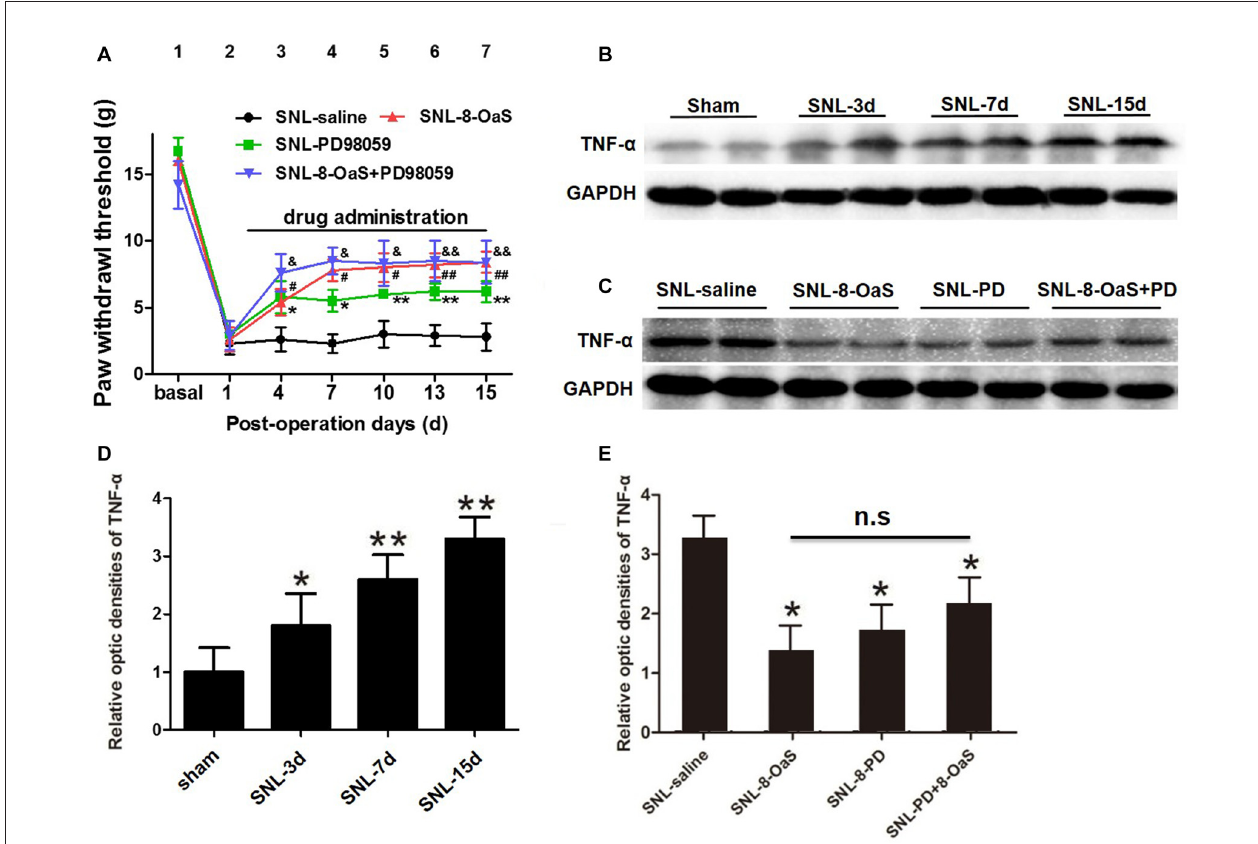
FIGURE 7 | 8-OaS suppressed SNL-induced spinal tumor necrosis factor-alpha (TNF- α ) expression via inhibiting ERK activation. Both administration of 8-OaS and PD98059 increased mechanical paw withdrawal threshold (PWT) of the SNL model. But co-treatment of 8-OaS and PD98059 did not result in further significant increases in PWT compared to the 8-OaS group and the PD98059 group (A) . ∗ P < 0.05, ∗∗ P < 0.01, SNL-PD98095 group compared with SNL-saline group. # P < 0.05, ## P < 0.01, SNL-8-OaS group compared with SNL-saline group. & P < 0.05, && P < 0.01, SNL-8-OaS+PD98095 group compared with SNL-saline group. SNL surgery increased the expression of TNF- α within the ipsilateral spinal dorsal horn from POD 3 to 15 (B,D) . ∗ P < 0.05, ∗∗ P < 0.01, compared with the sham group. n = 4 in each group. The expression of TNF- α were inhibited in 8-OaS and PD98059 treated groups but co-treatment of 8-OaS and PD98059 did not lead to further inhibition of TNF- α (C,E) . ∗ P < 0.05, compared with the SNL-saline group. n = 4 in each group. Duplication in the western blot analyses was introduced for accuracy